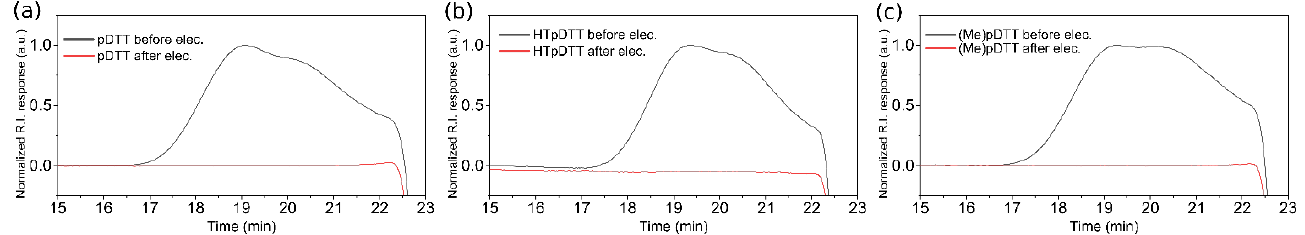
Figure 1. SEC elugrams before (black) and after (red) electrolysis of ( a ) pDTT, ( b ) HTpDTT, and ( c ) (Me)pDTT conducted at − 1.07 V vs. SCE with 3 mM AQ in 0.03 M Bu 4 NBF 4 /DMF. Electrolysis was halted once the consumed charge corresponded to a stoichiometry of 3 electrons per polymer chain. Note that these elugrams differ from those for pure polymers in the Supplementary Materials due to presence of AQ and supporting electrolyte.